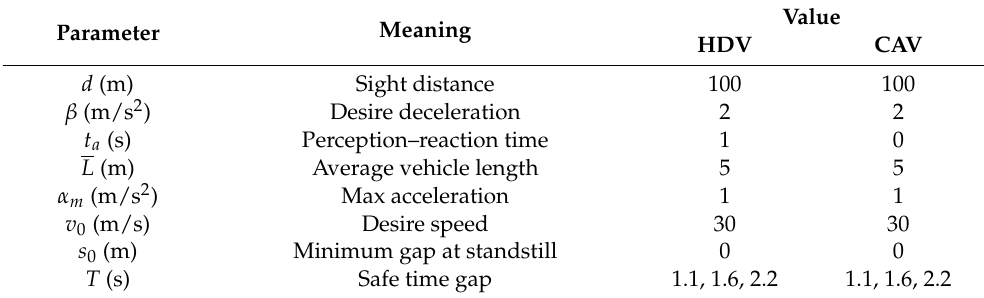
Table 1. Parameter settings of simulation